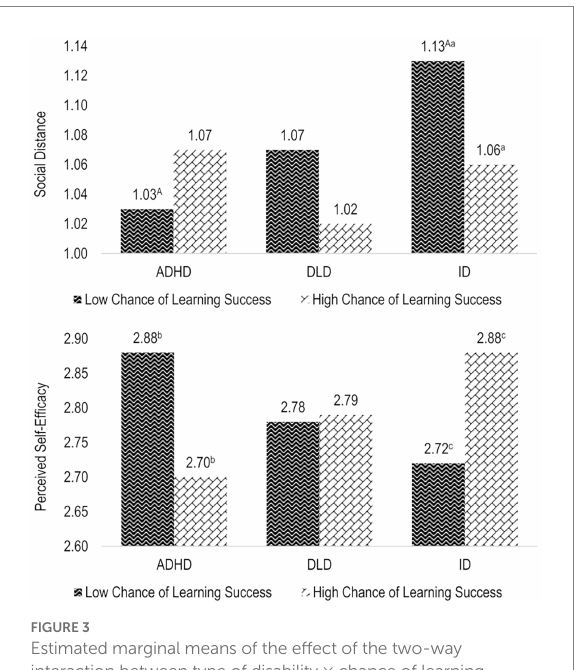
FIGURE 3 Estimated marginal means of the effect of the two-way interaction between type of disability × chance of learning success on social distance and perceived self-efficacy in the context of inclusive education. Means sharing the same capital letter differ significantly at p < 0.01. Means sharing the same lower case letter differ significantly at p < 0.05 (Sidak-corrected post hoc